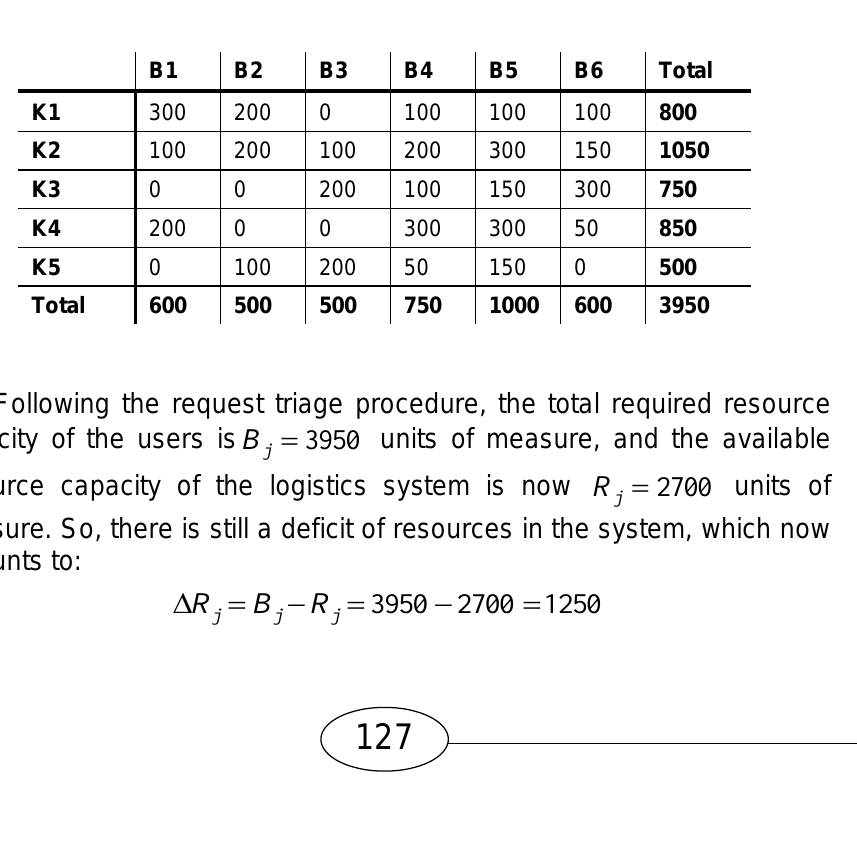
Table 2 – Overview of the user requirements after the